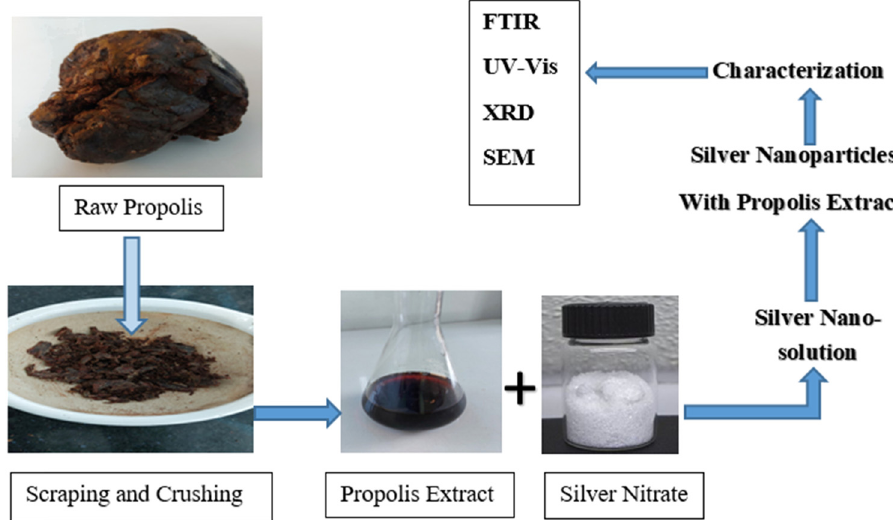
Figure 4: Schematic procedure for the biosynthesis of silver nanoparticles with